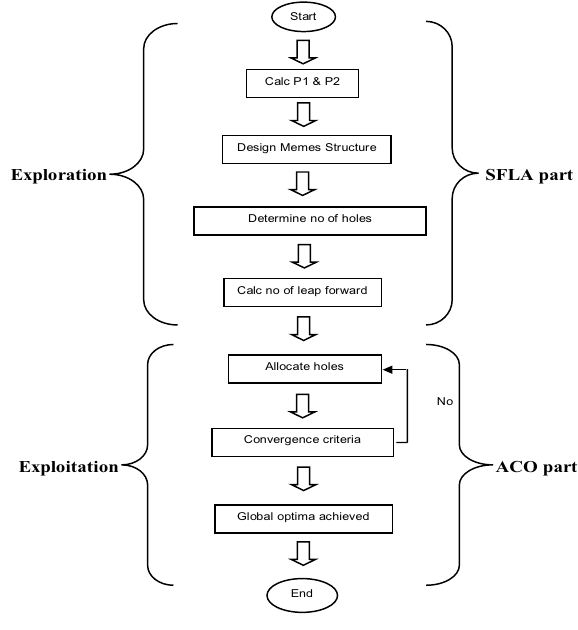
Fig. 1 Flow diagram of proposed hybrid SFLA-ACO